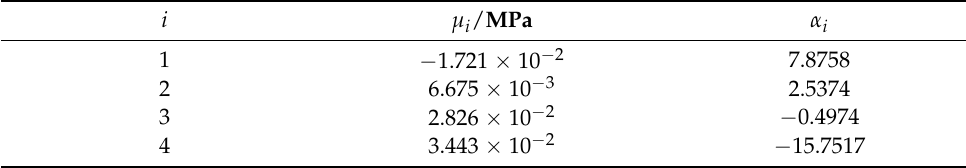
Table 2. OCA parameters of forth-order Ogden equation.